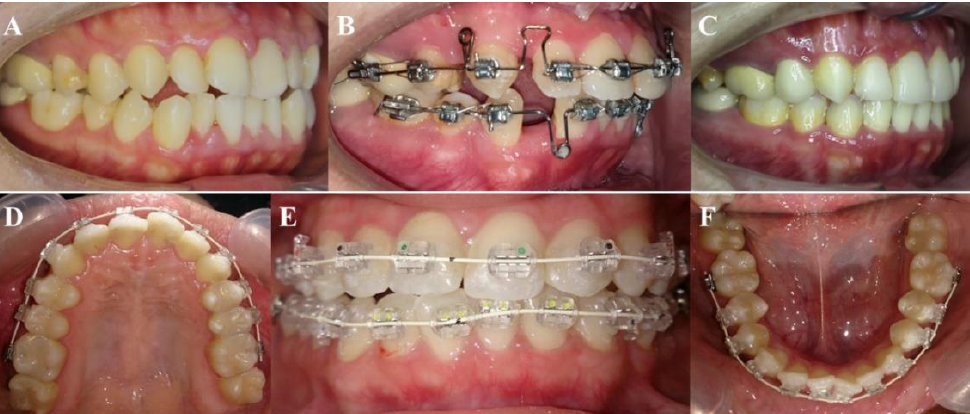
Figure 7. Use of shape memory NiTi wire and Teflon-coated NiTi wire to close the space in ortho- dontic treatment: ( A ) before treatment; ( B ) during treatment; ( C ) after treatment for the NiTi alloy and ( D ) before treatment; ( E ) during treatment; and ( F ) after treatment for the Teflon-coated NiTi